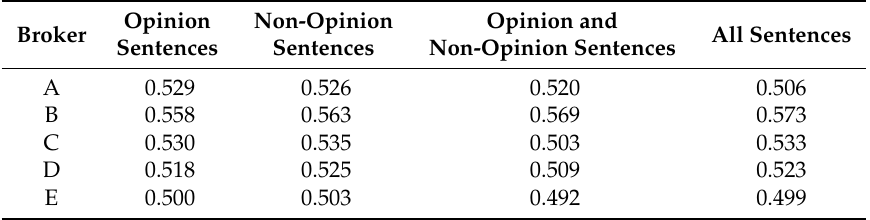
Table 6. Summary by broker in forecasting excess returns with our method. Macro-F1 is a measure.